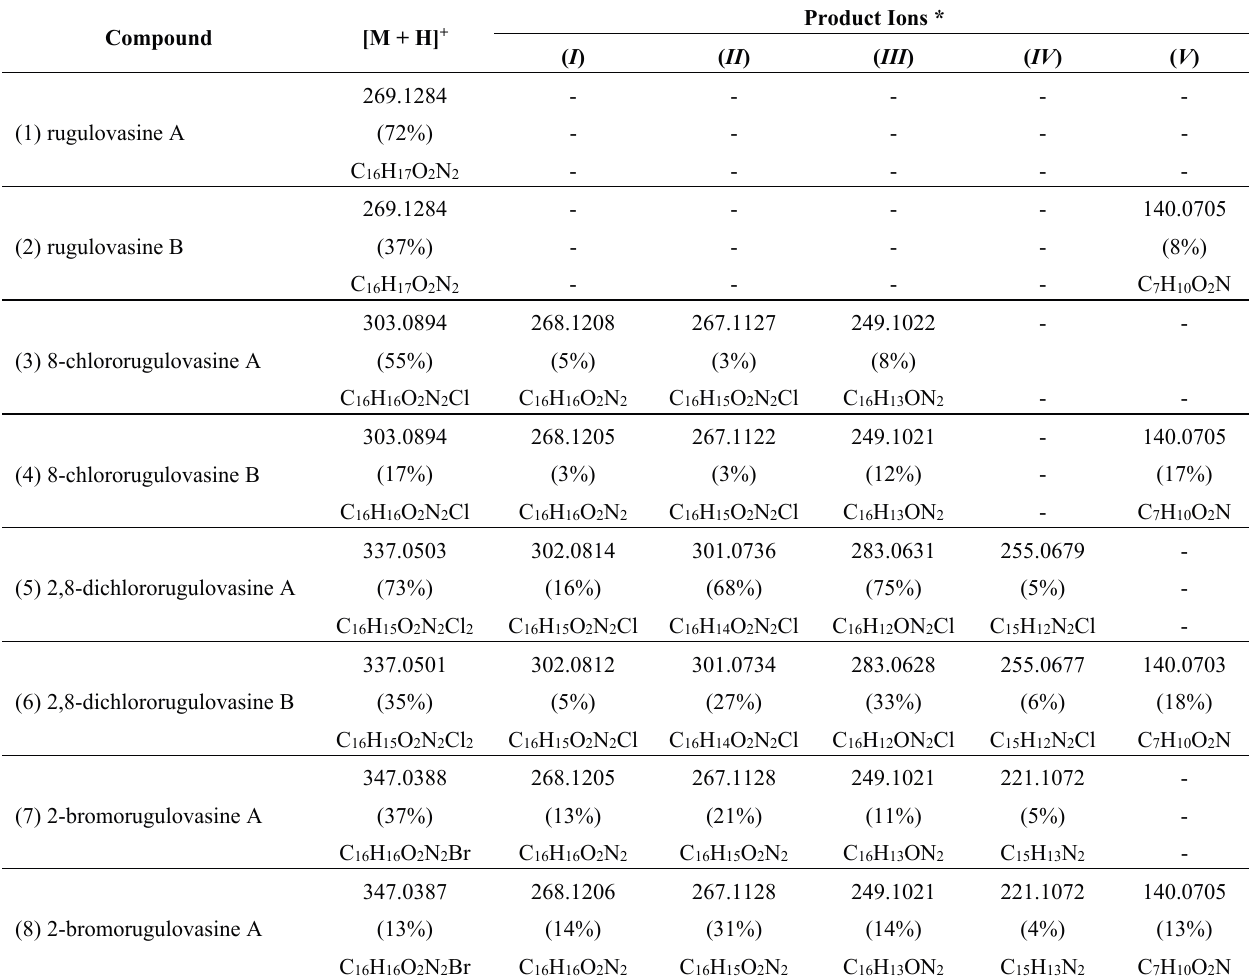
(first line). Relative intensities based on from the base peak ion in the MS/HRMS spectra (second line). Elemental composition obtained from of each accurate masses (third